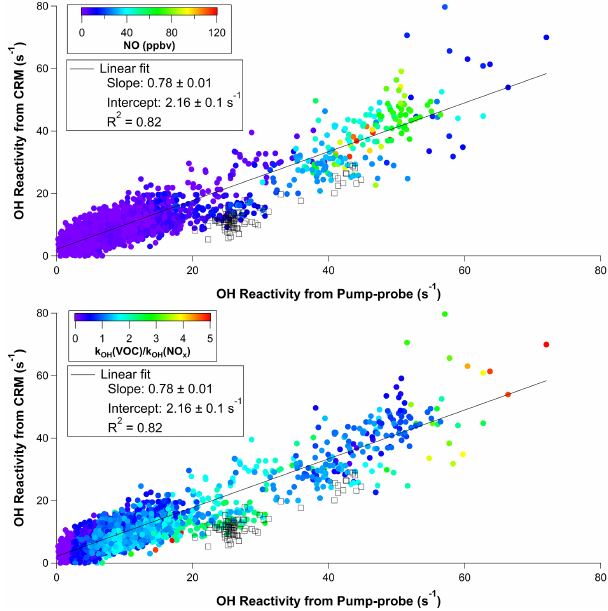
Figure 7. Scatter plot of OH reactivity measurements (CRM vs. pump–probe) as a function of NO mixing ratios (top) and as a func- tion of the ratio of OH reactivity from VOCs to OH reactivity from NO x (bottom). Black squares show measurements performed from 19:00LT on 21 October to 07:30LT on 22 October, when signifi- cant differences were observed between the CRM and pump–probe measurements (see text). Note that the pump–probe measurements have been averaged to match the time stamp and the averaging time of the CRM